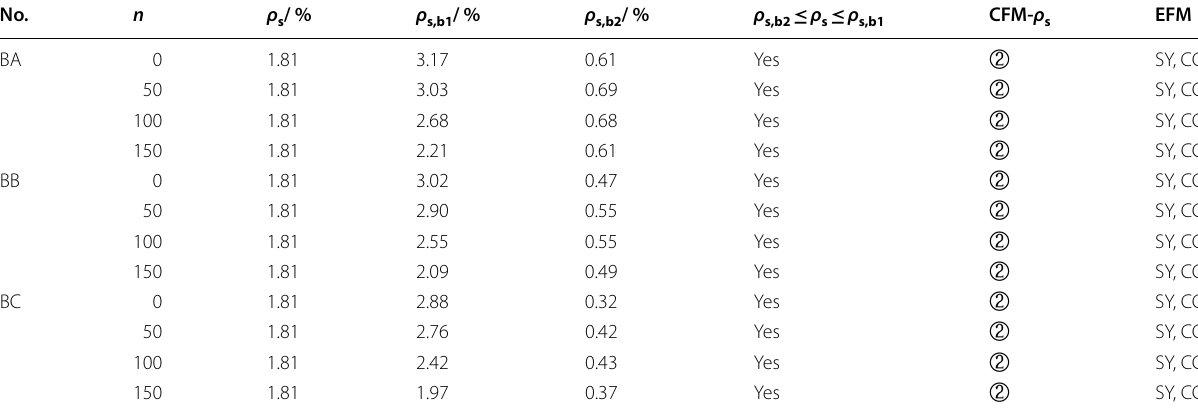
Table 10 Simplified bending capacity formulas development for ECC-concrete composite and ECC specimens ECC‑concrete composite specimen ECC specimen I-Strain and stress distribu-